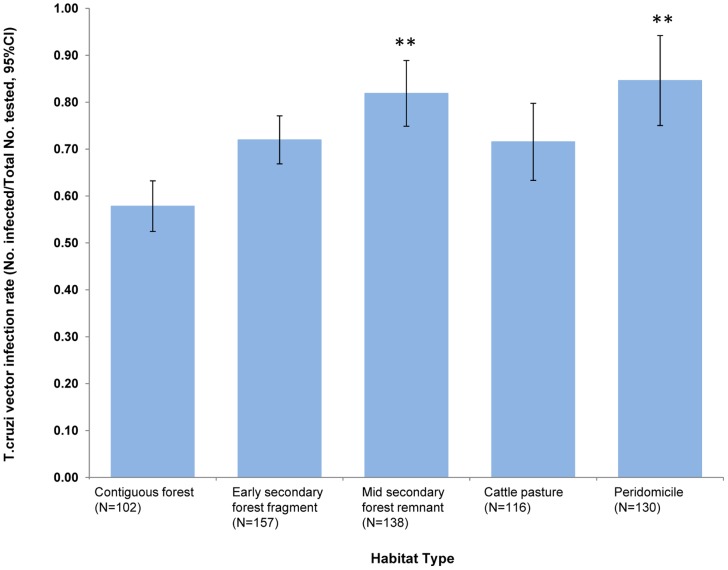
Proportion of R. pallescens vectors infected with T. cruzi in each habitat type: Contig-contiguous forest, ES-early secondary forest, MS-mid secondary forest remnant, PD-peridomestic.**Significantly higher proportion of infected vectors p<.01 compared to vector infection rate in contiguous forests (Generalized linear mixed model: T. cruzi positive Habitat type (fixed)+ Site (random), quasibinomial errors, link = logit).